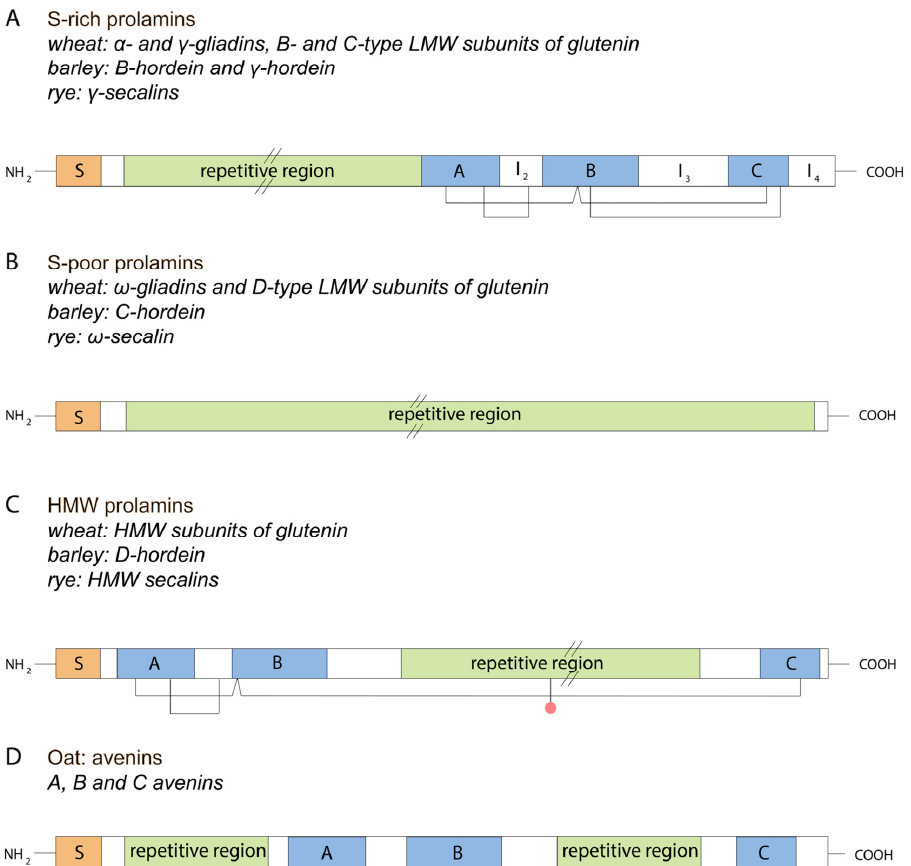
Figure 3. Schematic representation of typical structure of prolamin group members: S-rich, S-poor, HMW and avenins. S—signal peptide; A, B, C—conserved regions, lines—disulfide bonds, red circles—unpaired cysteine residue, I 2 –I 4 —variant regions; parallel lines—contracted repetitive region.